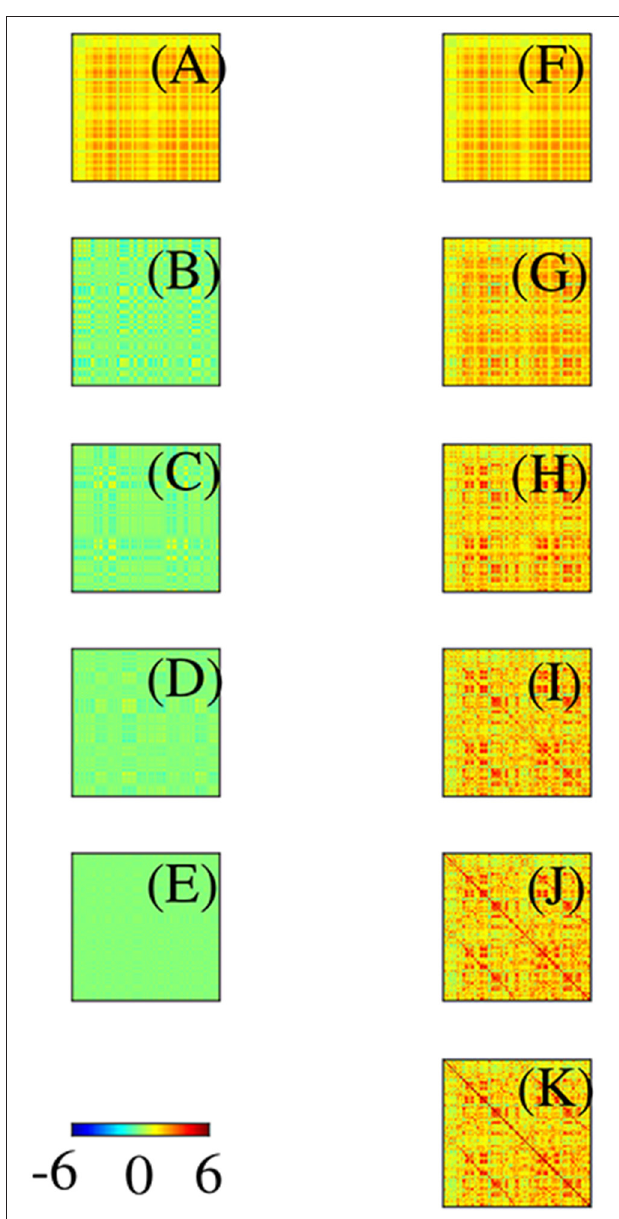
FIGURE 10 | Modal contributions to FC in connection-matrix form, with scale as in the color bar. (A–E) Contributions from each of the first 5 modes in order. (F–J) Cumulative sums of the frames on the left. (K) Exact